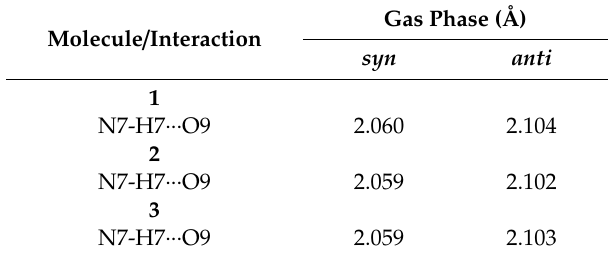
Table 4. Average intramolecular hydrogen bonds lengths (Å) in 1-3 of DFT optimized structures. Molecule /